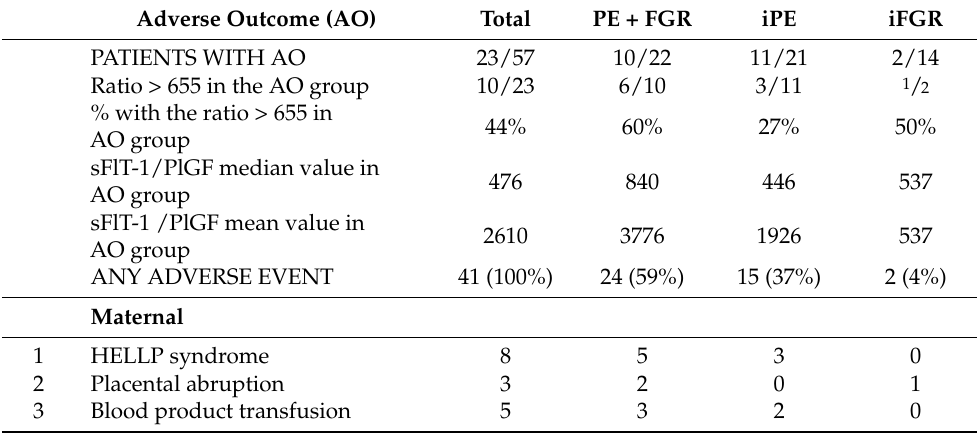
Table 7. Adverse outcomes, their occurrence in the PE + FGR, iPE and iFGR groups and relation to the sFlt/PlGF ratio cutoff